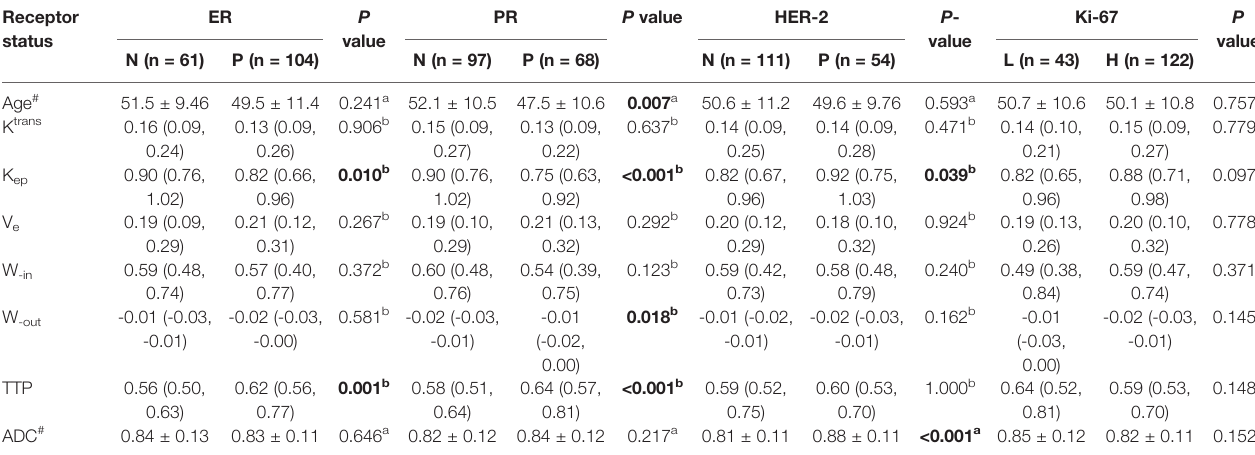
TABLE 1 | MRI parameters of different receptor statuses in breast